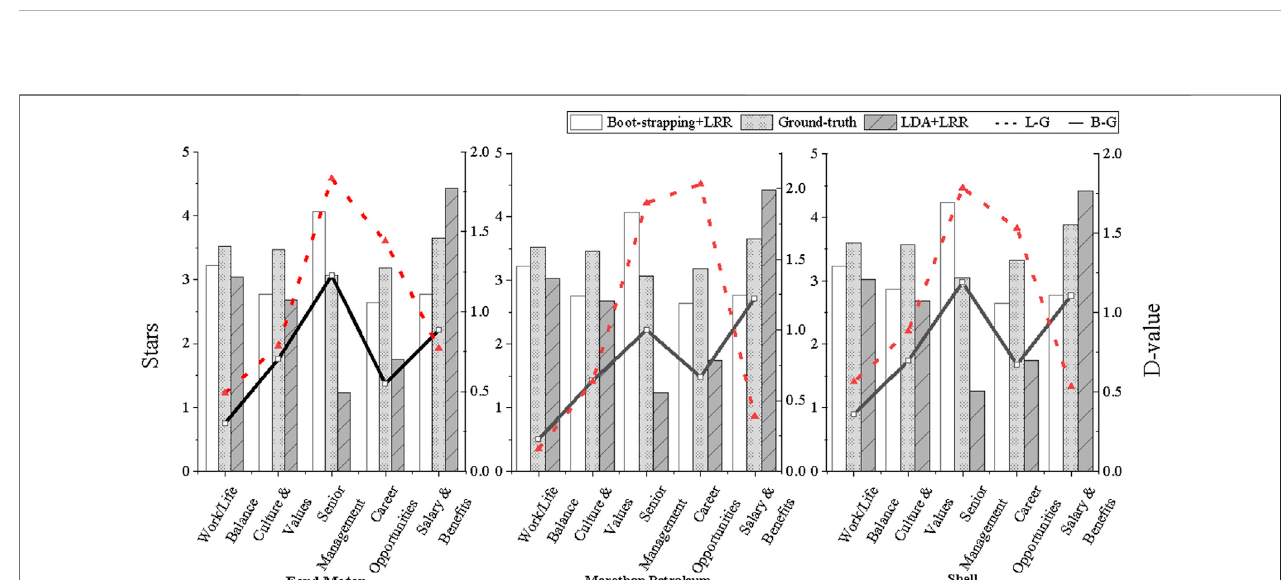
FIGURE 4 | The aspect score of the review text of the employees from the three companies. “ B-G ” and “ L-G ” respectively represent the difference value (D-value) between the output value of the two algorithms “ bootstrapping + LRR ” and “ LDA + LRR ” and the true value.